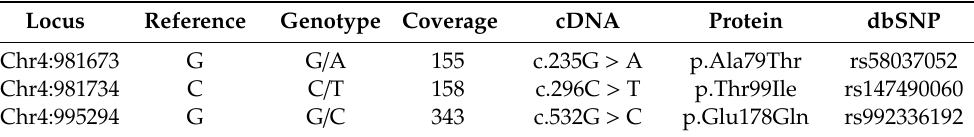
Table 1. Next-generation sequencing results of the IDUA gene.